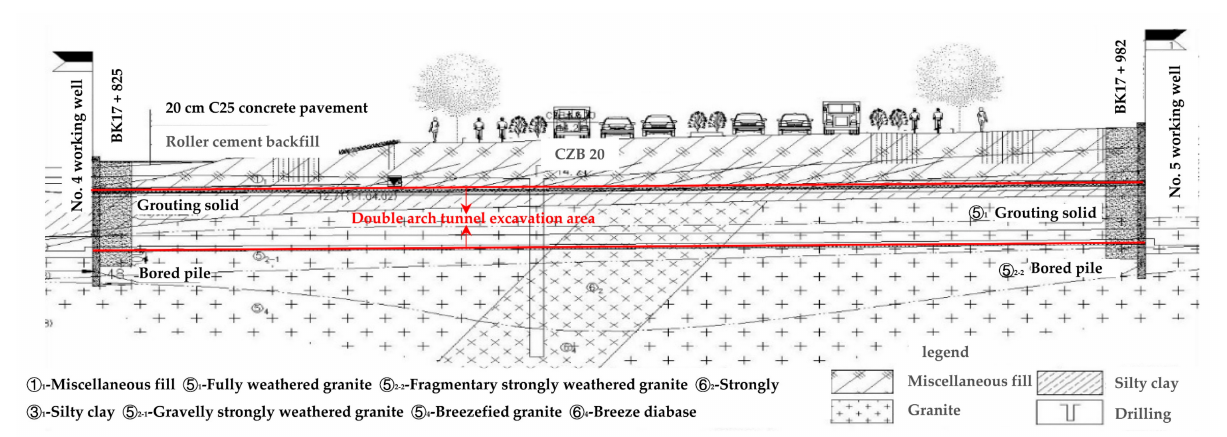
Figure 1. Longitudinal profile of the double-arch